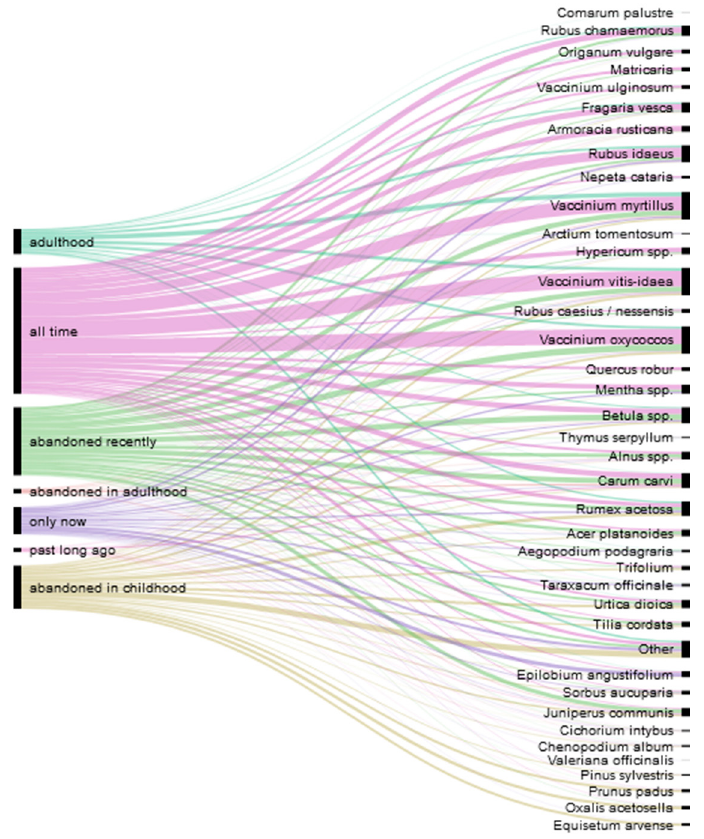
Figure 3. Diachronic distribution of wild plant use over the lifetime of the study